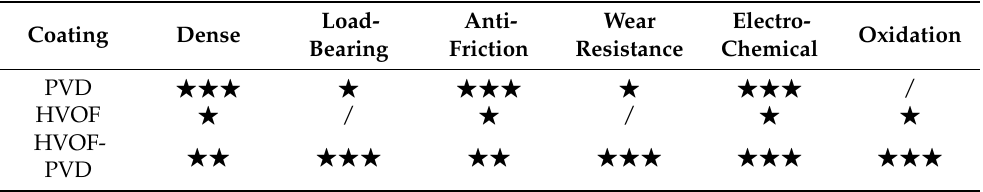
Table 1. Performance summary of PVD, HVOF and HVOF-PVD coatings according to the literature in Section 3.